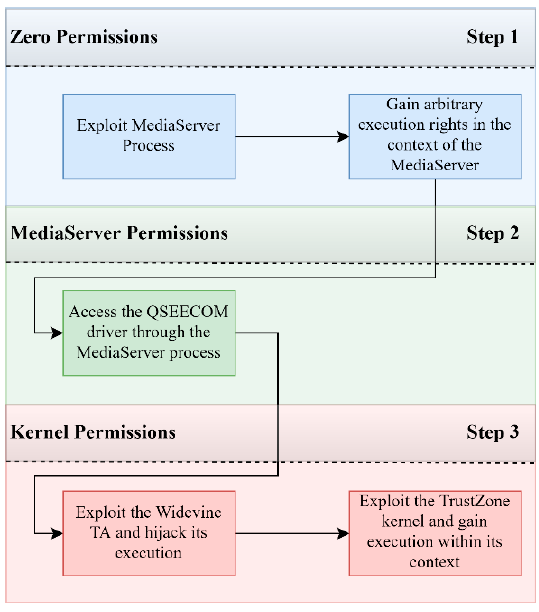
Figure 7. Privilege Escalation to TrustZone Kernel.